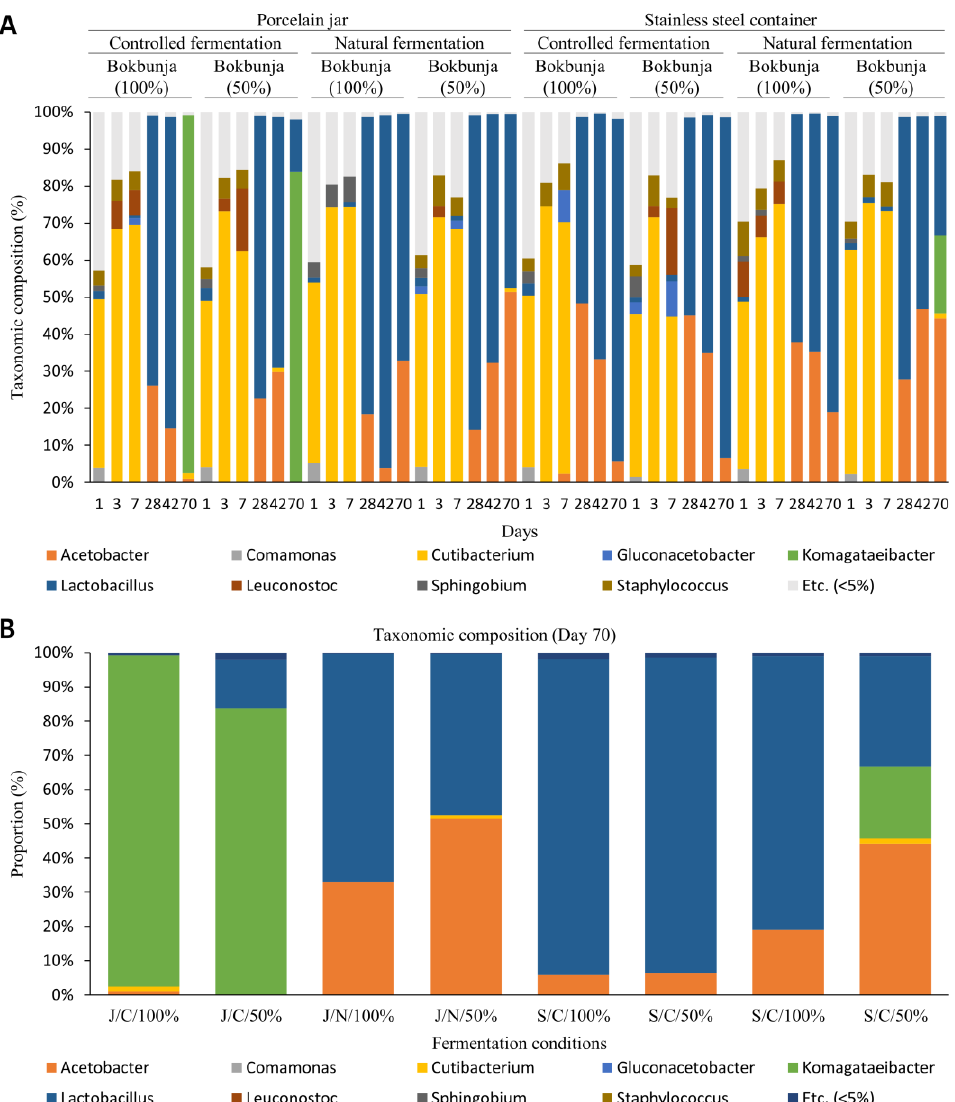
Figure 4. Changes in the taxonomic composition according to fermentation condition and